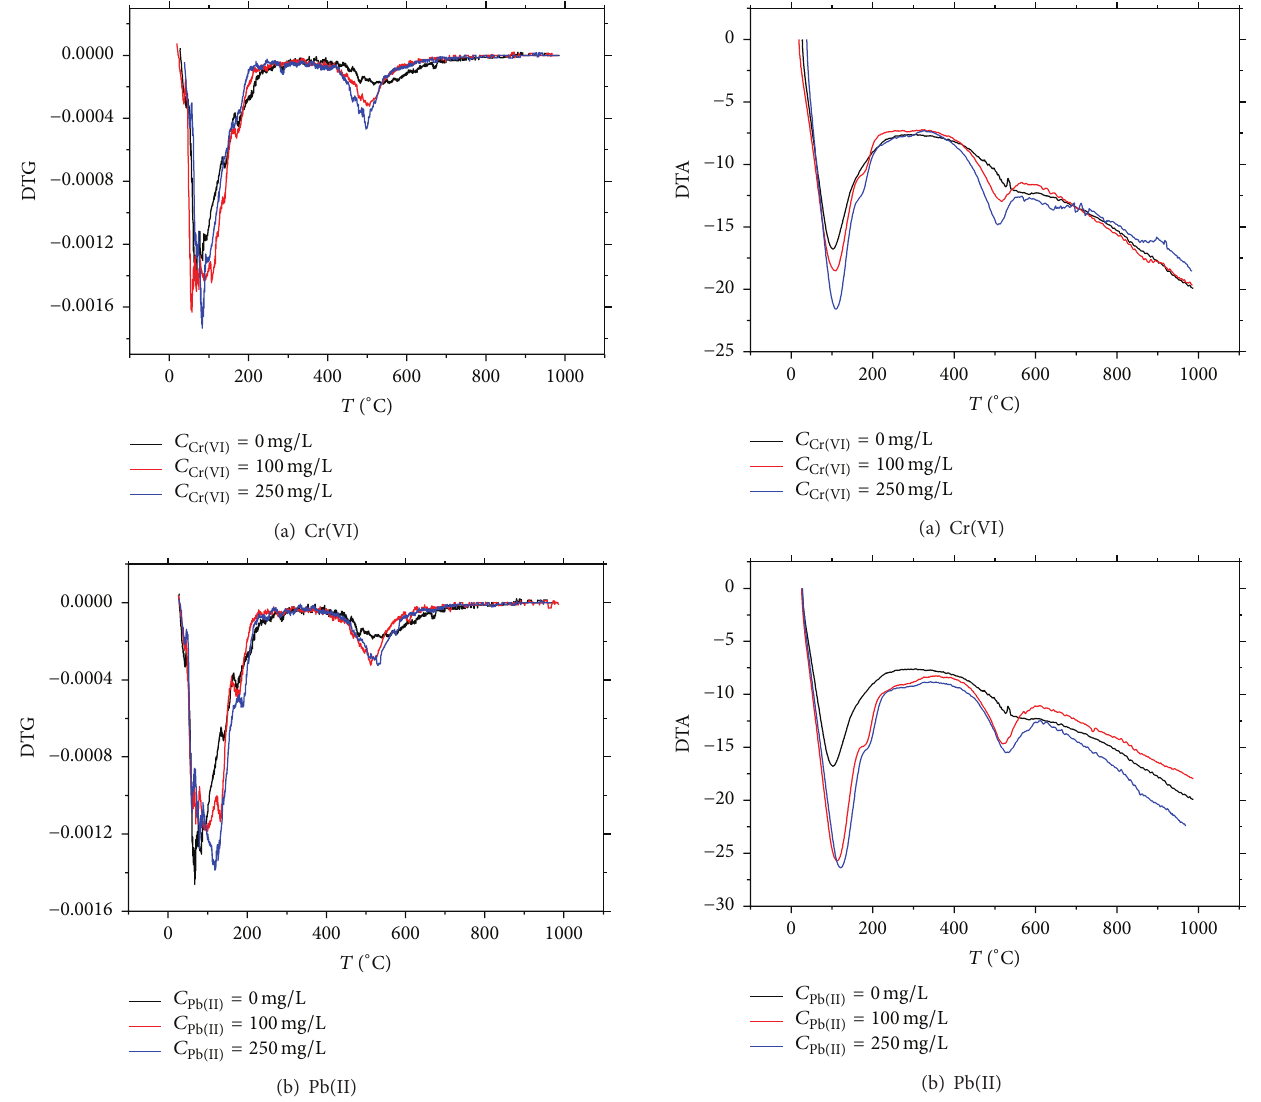
Figure 10: Derivation thermogravimetry curvilinear (DTG/TG-T curvilinear).